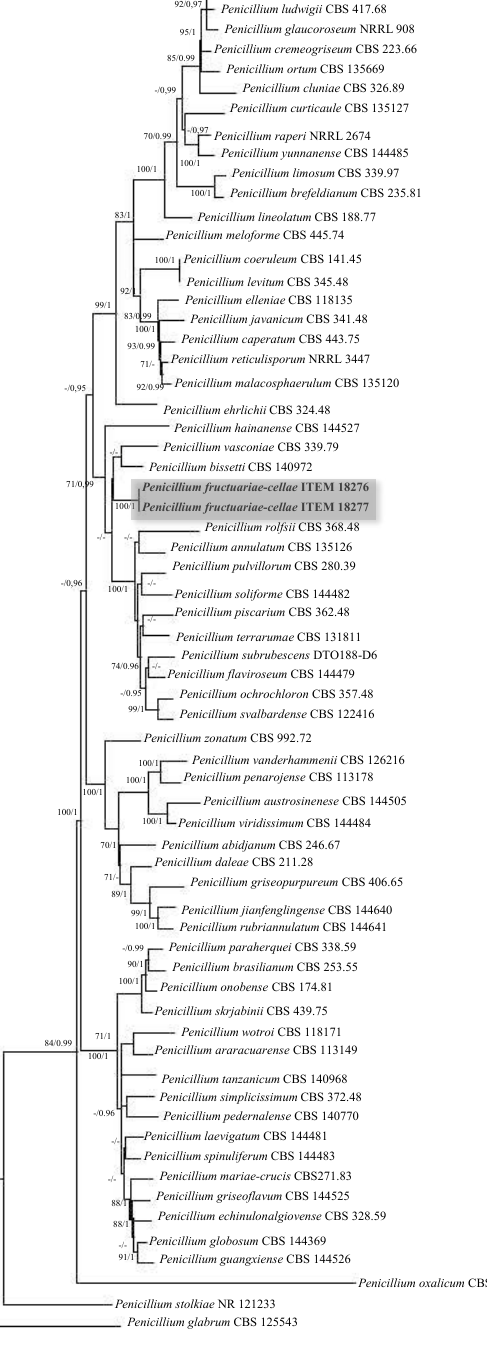
Figure 1. Phylogenetic tree of combined sequences of Penicillium spp. (a) Maximum Likelihood combined ( benA+CaM+ITS+rpb2 ) tree of P. fructuariae-cellae ITEM 18277 (Pdb1) and ITEM 18276 T (P3) and representative taxa of Penicillium section Lanata – divaricata . Penicillium stolkiae CBS 315.67, P. oxalicum CBS 219.30 and P. glabrum CBS 125543 are outgroups. (b) Maximum Likelihood combined ( benA+CaM+ITS+rpb2 ) tree of P. bilaiae ITEM 18278 (Pls8) and representative taxa of Penicillium section Sclerotiora . Penicillium levitum CBS 345.48 is outgroup. The BI posterior probabilities values and bootstrap percentages of the ML analysis are indicated above the nodes (BS/pp). Values less than 70% bootstrap support in the ML analysis and less than 0.95 posterior probability in the Bayesian analysis are indicated with a hyphen. Branches with high support are